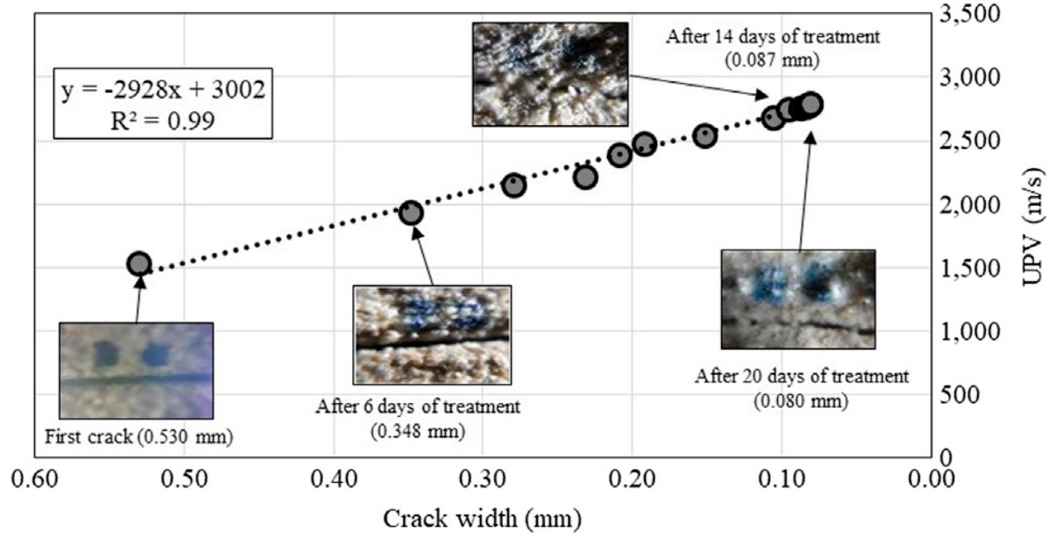
Figure 10. The plot of ultrasonic pulse velocity (UPV) value vs. crack width of MICP-treated sample along 20 days of treatment. Adapted with permission from [84]. 2019, Elsevier.